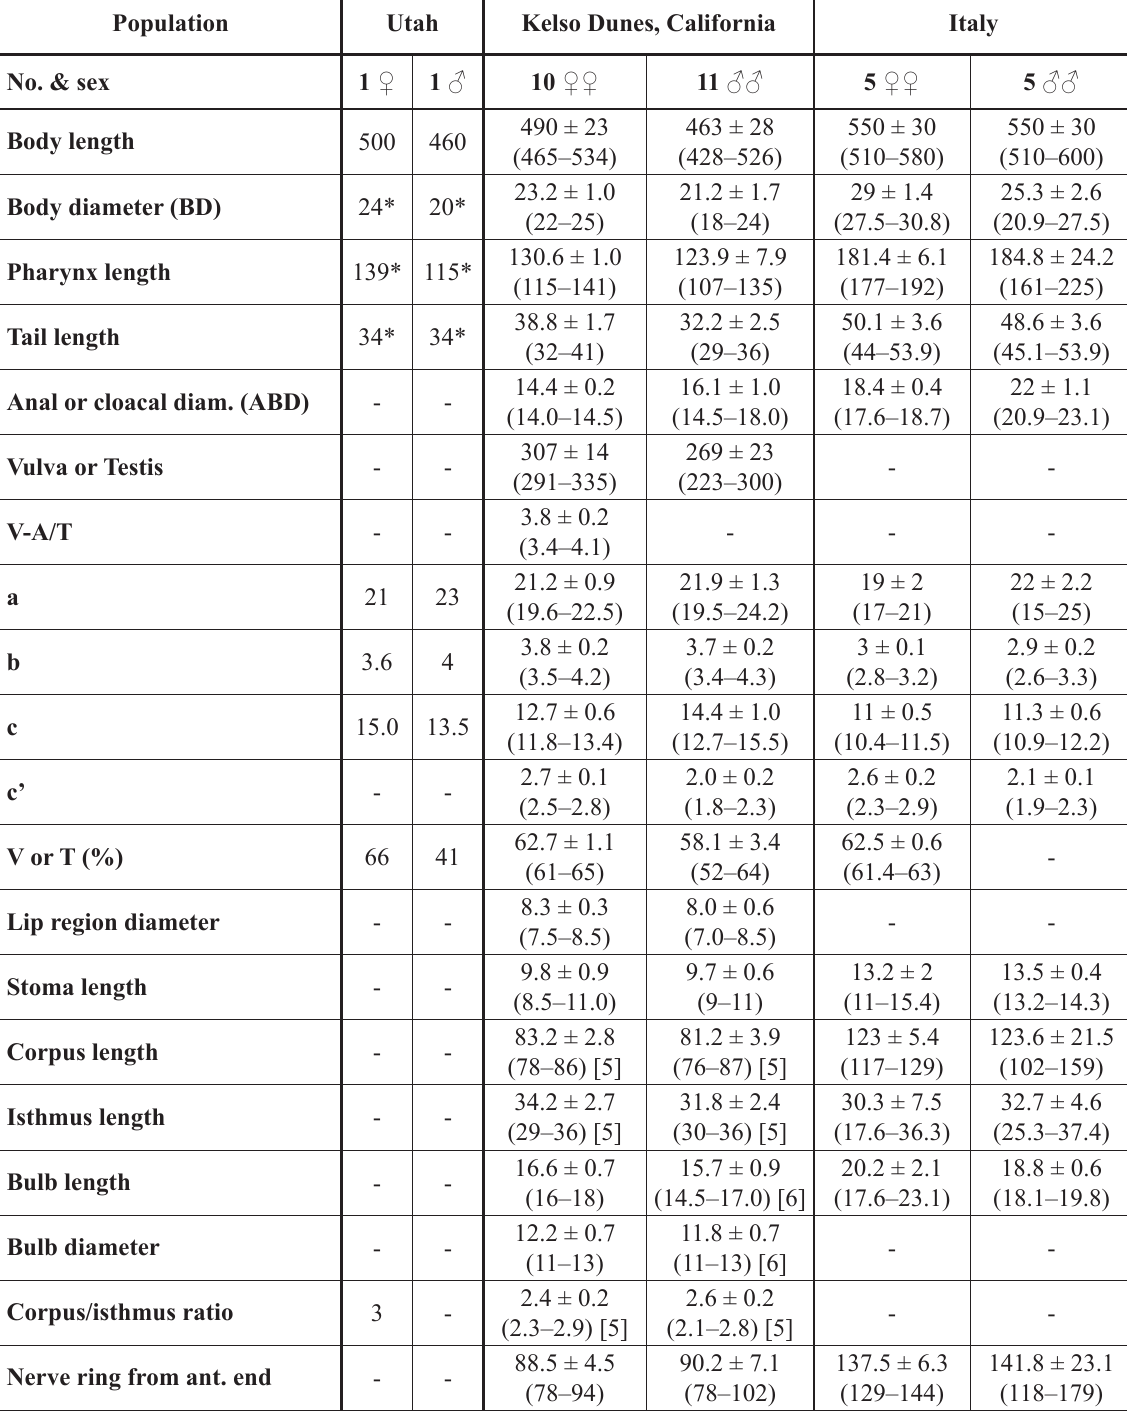
Table 1. Measurements (in µm) of Stegelleta incisa (Thorne, 1937) from Kelso Dunes, California compared with the type population of S. incisa from Utah and a bisexual population described by Orselli & Vinciguerra (2002) from Italy under the name S. ophioglossa Andrássy, 1967 (presented as mean ± s.d. and (range) or only range). * Calculated from data in original publication; ** number of annuli from anterior end to nerve ring, excretory pore and deirid, respectively; ¤ estimated from drawings in original publication; - indicates that data is not available or not applicable; figures within [ ] indicate the number of specimens